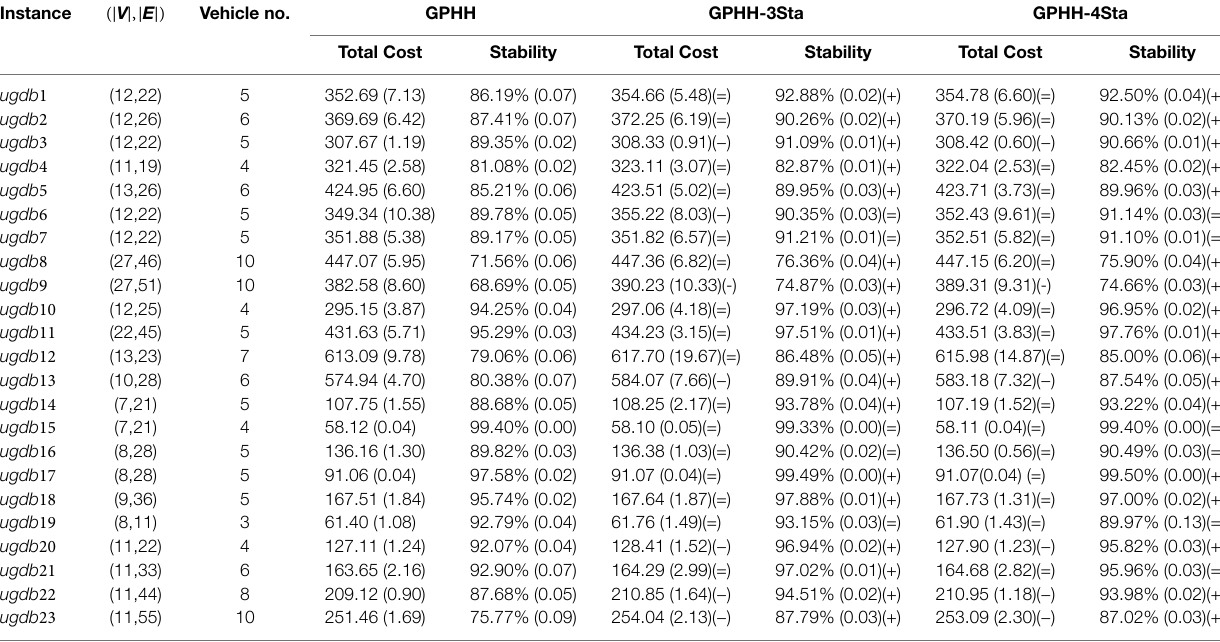
TABLE 3 | The mean and standard deviation for the total cost and stability of the compared GPHHs on the test sets. (+), (−), and (=) mean that GPHH- 𝛼 Sta is significantly better than, worse than, and comparable with the traditional GPHH. Instance